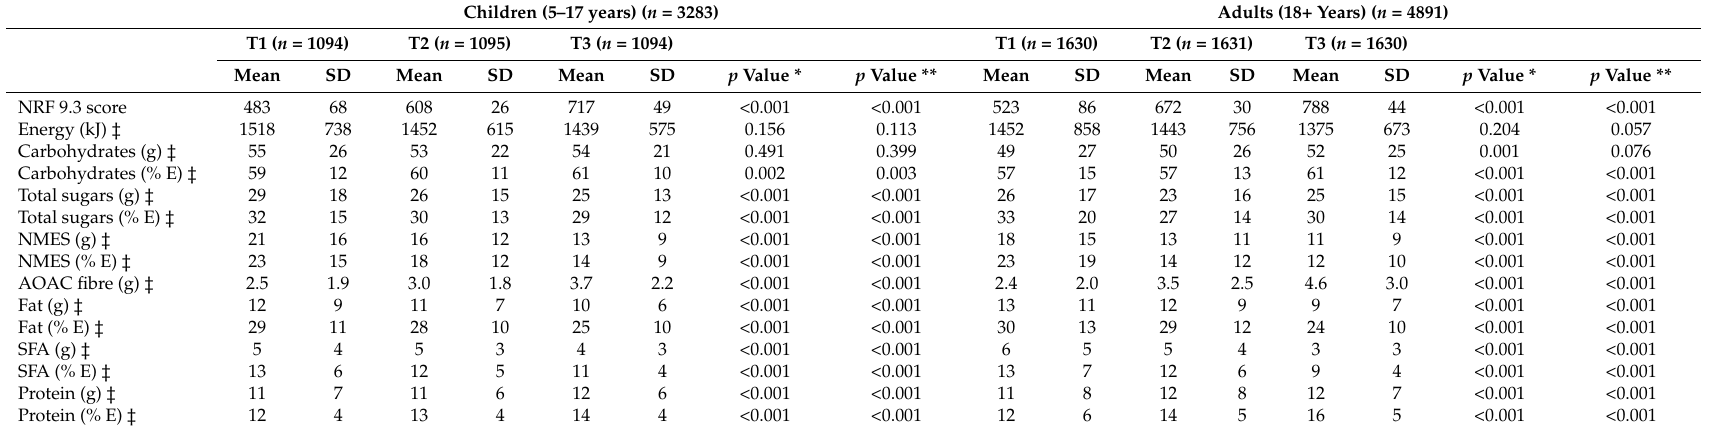
Table 3. Mean (SD) intake of energy and macronutrients at breakfast across tertiles of NRF 9.3 score by age